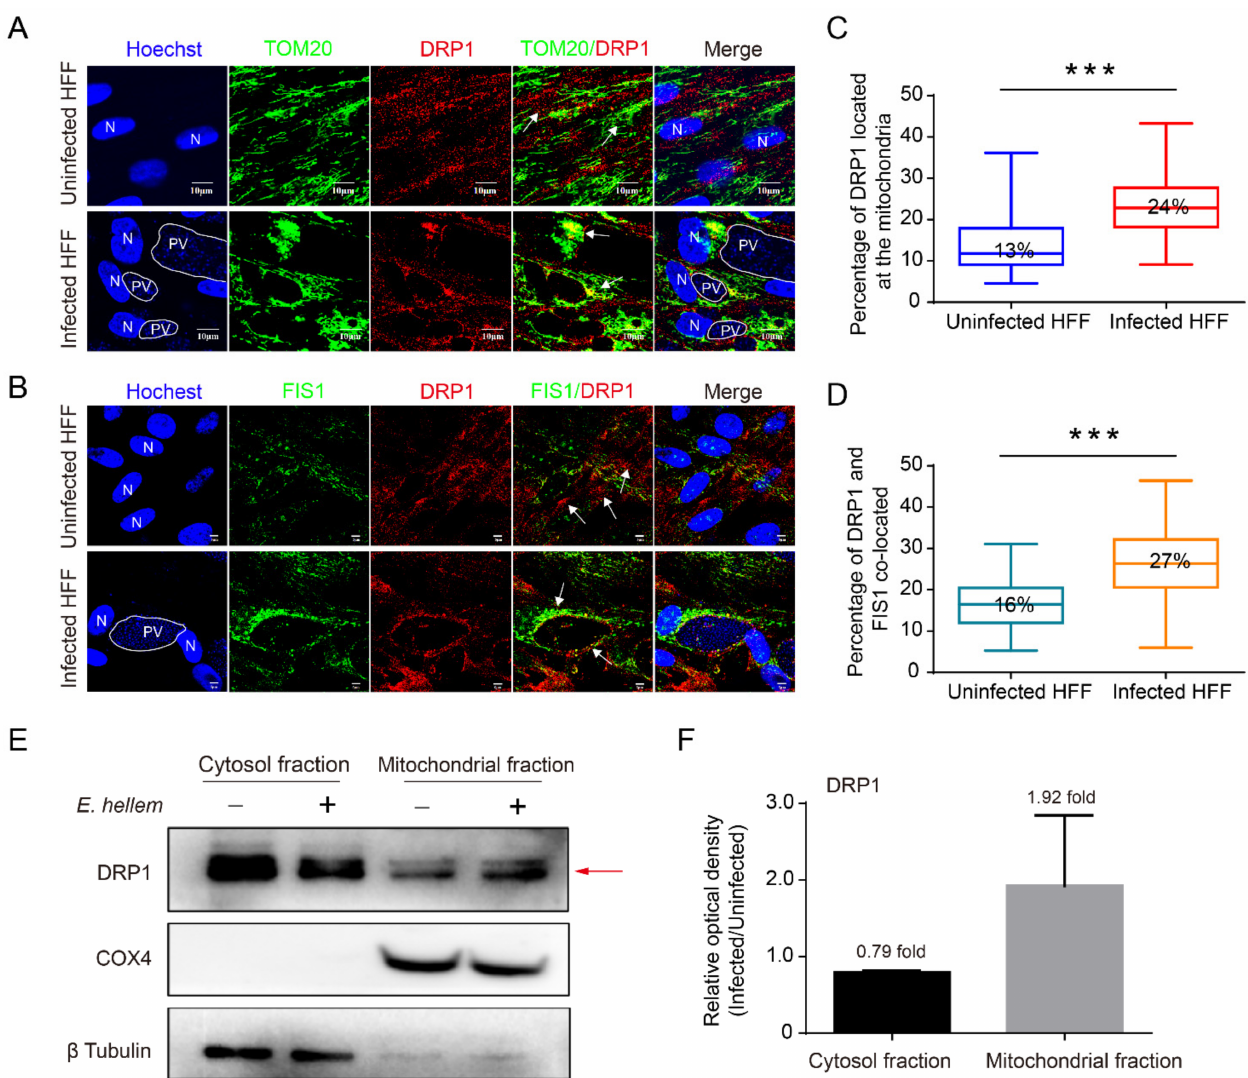
Figure 5. Subcellular localization of DRP1 in E. hellem -infected HFF cells at 48 hpi. ( A , B ) Obser- vations of the subcellular localization of DRP1 by laser scanning confocal microscope. Nuclei are labeled with Hoechst (blue); DRP1 (red), TOM20 (green), and FIS1 (green) are labeled with relevant antibody, respectively. The white arrow indicates the co-localization of DRP1 with TOM20 and FIS1. PV, parasitophorous vacuole; N, nucleus. Statistical analysis of the co-localization of DRP1 with TOM20 ( C ) and FIS1 ( D ). At least 30 cells were counted for each sample. Data of at least three separate experiments are expressed as boxplots. *** p < 0.001. ( E ) The localization of DRP1 in cytoplasm and mitochondria. Cytoplasm and mitochondria fraction of 48 h infected HFF cells were isolated. COX4 and β Tubulin was used as an internal control. Red arrow shows the protein band with significant changes. ( F ) Comparison of the relative optical density of DRP1 immune blots between infected and uninfected